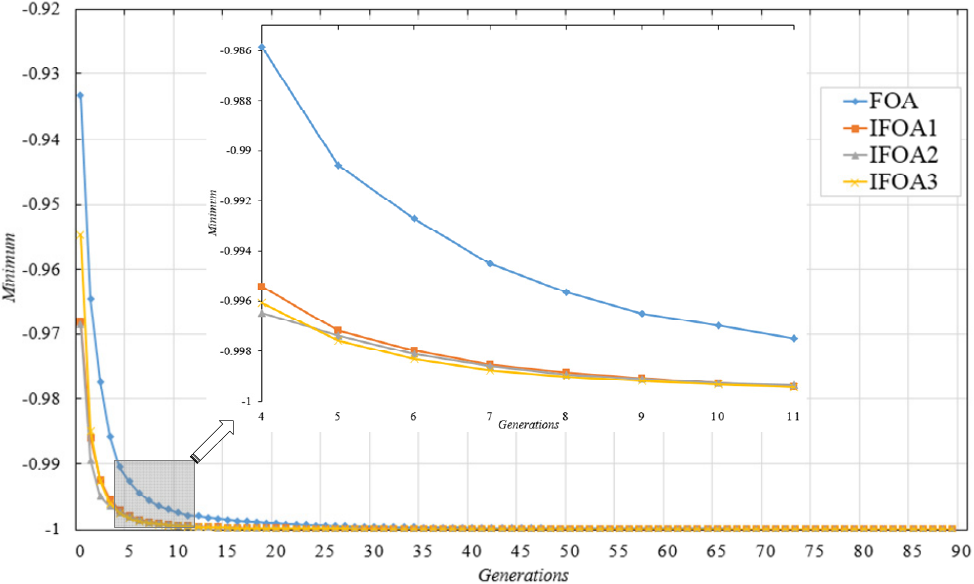
Figure 6. Optimization result of FOA and IFOAs with different inertia weights.